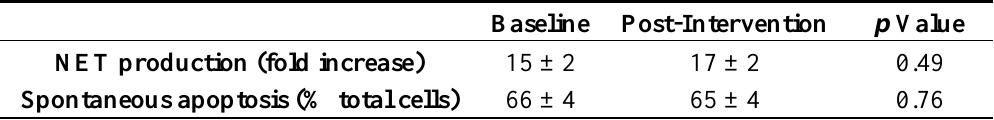
Table 3. Neutrophil extracellular trap (NET) production and spontaneous apoptosis (at 24 h) at baseline and following